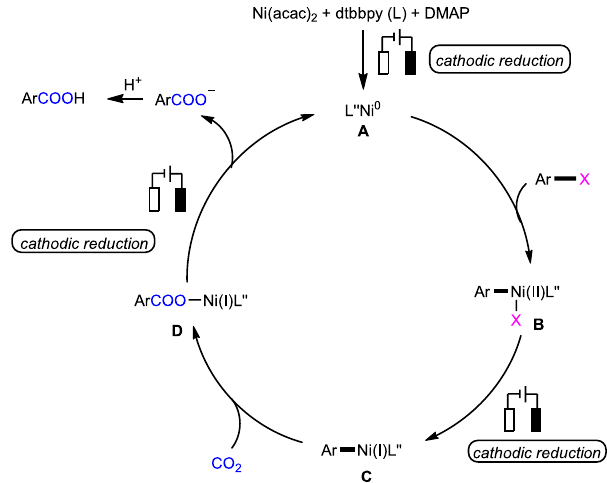
Fig. 8 Proposed mechanistic cycle. Proposed reaction pathway is started up via the electro-generated Ni(0)